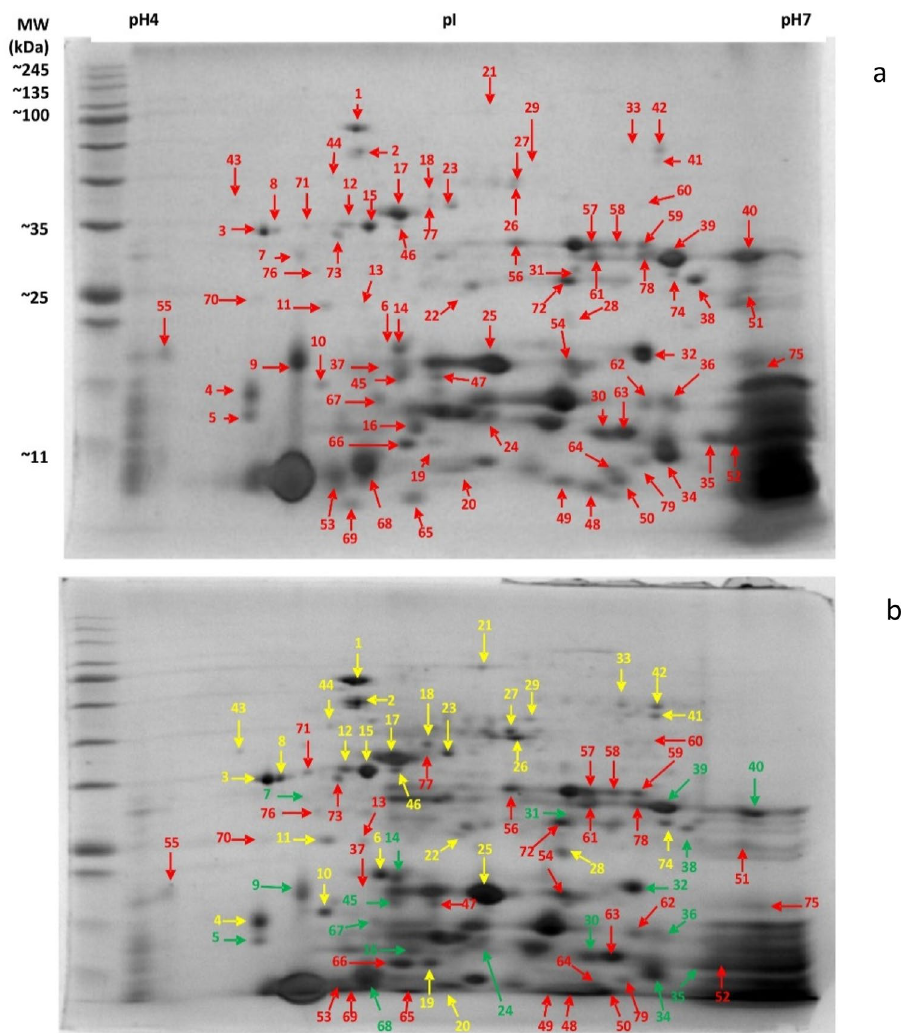
Figure 10. The 2D gel protein image of limonene treated (1XMIC) E. coli cells. ( a ) Control, ( b ) treatment; yellow arrow = upregulate | green arrow = downregulate | red arrow = no change (PDQuest Advanced 2-D